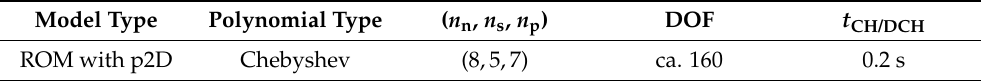
Table 1. Summary of the model setting for ROM used for parameter identification